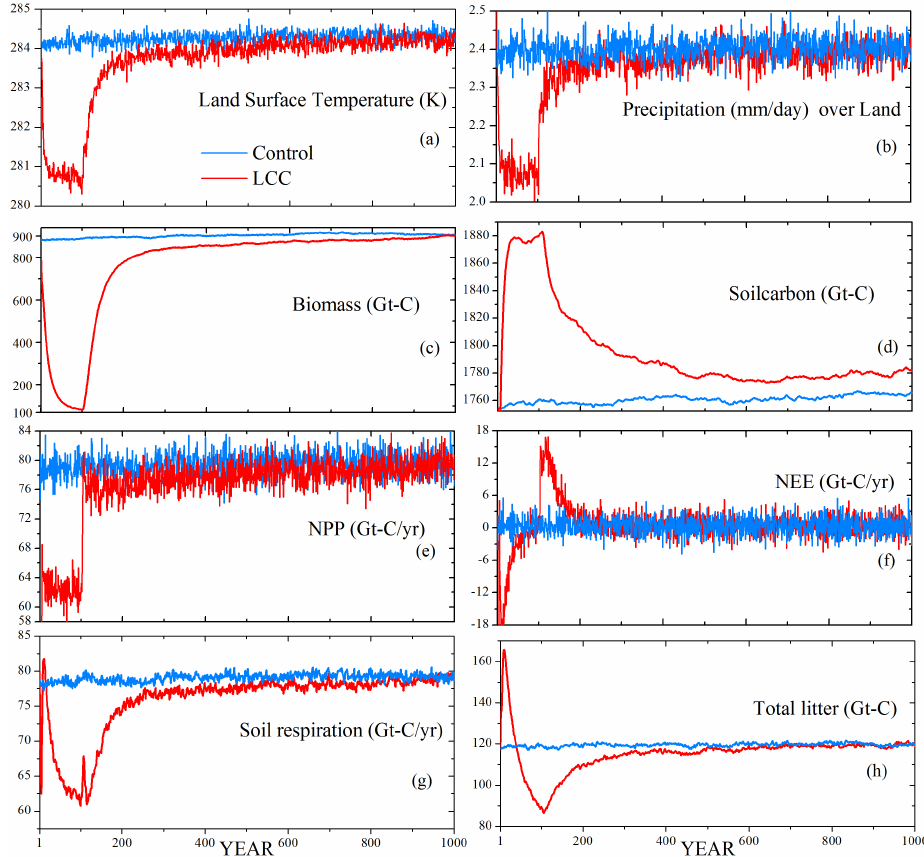
Fig. 1. Evolution of annual mean (a) land surface temperature, (b) precipitation over land, (c) biomass, (d) soil carbon, (e) net primary productivity (NPP), (f) net ecosystem exchange (NEE), (g) soil respiration (includes heterotrophic respiration and disturbances), and (h) total litter for the 1000-yr control and LCC